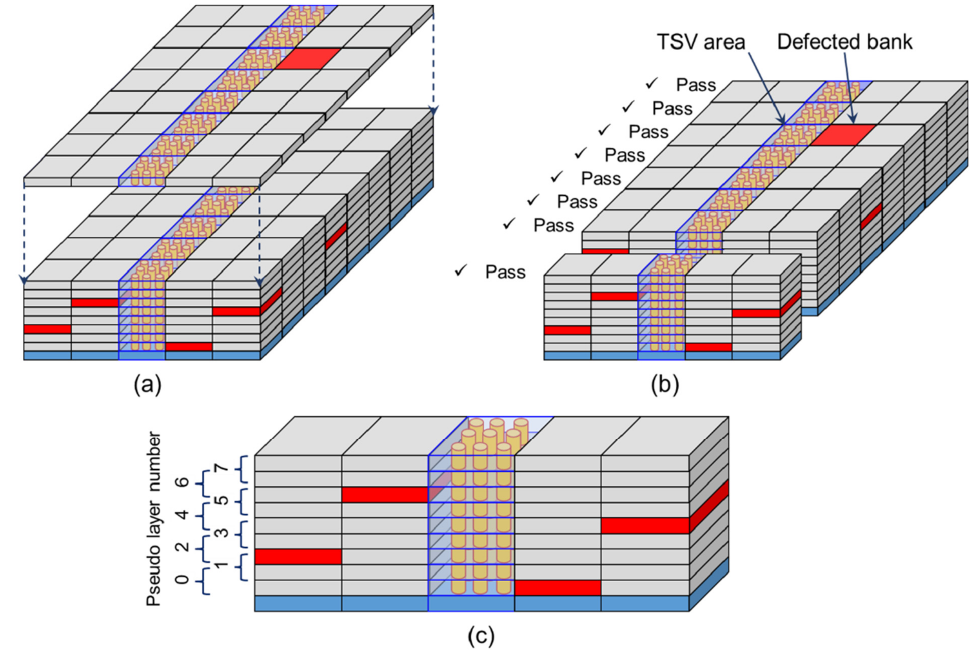
Figure 49. 3D redundancy techniques for: ( a ) layer addition to cover circuit resources, ( b ) bank replacement among a set of stacked bank groups, and ( c ) pseudo layer-by-layer operation.